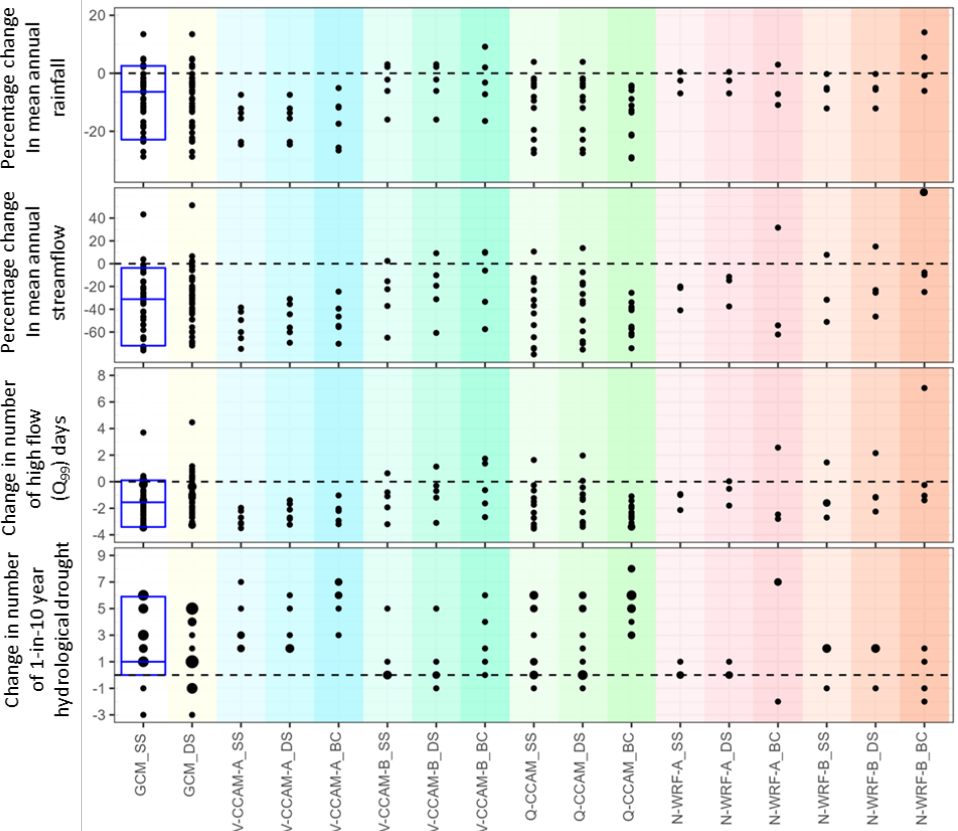
Figure 7. Modelled changes in the mean annual rainfall, mean annual streamflow, high flow days, and hydrological drought from the different climate projection products and methods used to generate future daily rainfall series for Catchment 415207 Wimmera River at Eversley (acronyms for the datasets and methods on the x -axis are described in Table 1 and Section 2, definitions for high flow days and the 1-in-10-year hydrological drought on the y -axis are described in the first paragraph of Section 3, blue boxes for GCM_SS show the median and 10th and 90th percentile values from the simulations informed by the 42 GCMs, for the discrete (integer value) hydrological drought metric larger dots indicate more modelling results showing the projected change).